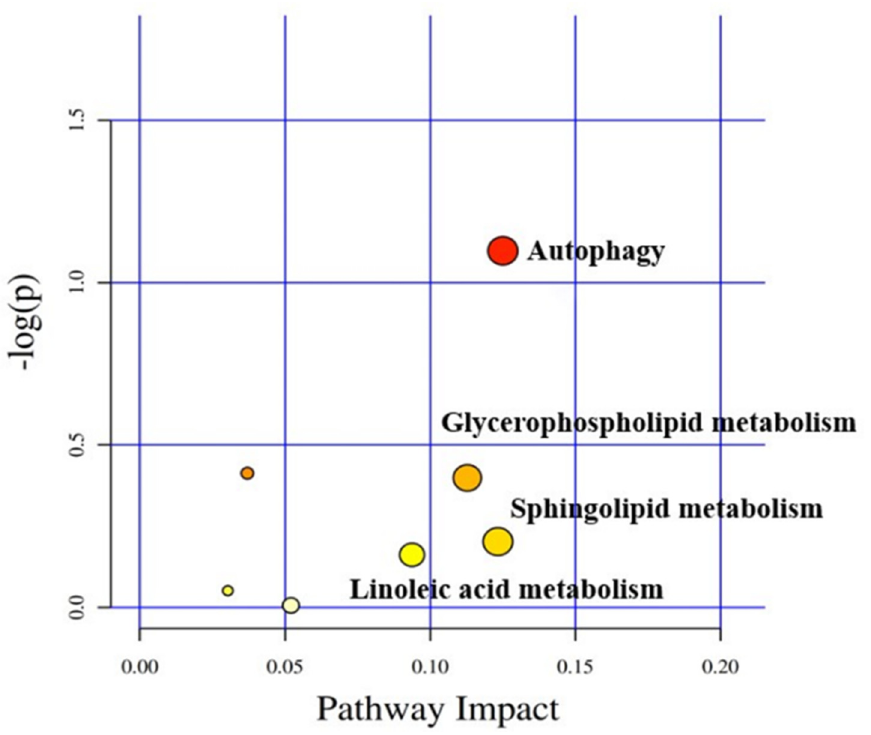
Figure 3. The pathway enrichment bubble plot of differential lipid metabolites in the liver of juvenile American eels in PSPc0 group and PSPc900 group. Each bubble in the figure is the expression of influence combined with the p -value. Different bubbles represent different metabolic pathways, and the larger the bubble, the greater the influence of the pathway. Different colors indicate different degrees of metabolic pathways, and the darker the color, the greater the changes in pathways. A higher − log(p) means a lower p -value. According to the importance and influence of metabolic pathways, the names of the most relevant metabolic pathways were labeled.